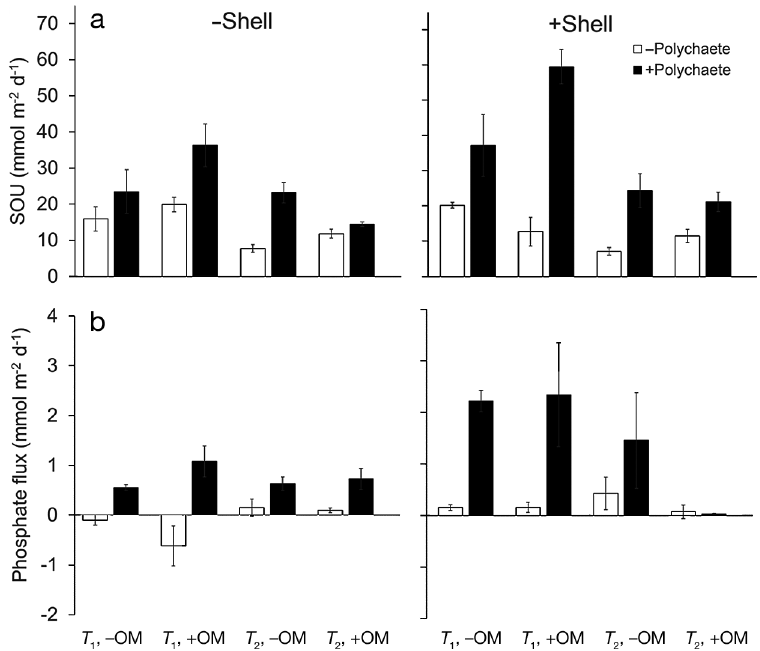
Fig. 5. Effects of shells on (a) sediment oxygen uptake (SOU) and (b) phosphate fluxes in sediments with different organic matter loads (+OM/−OM) and at 2 different sampling times ( T 1 : after 1 wk; T 2 : after 3 wk) in the presence and absence of polychaetes (−Polychaete/ +Polychaete) Table 5. ANOVA of sediment−water fluxes of ammonium, nitrate and nitrite in sediments affected by the experimental treatments. OM: organic matter Significant (p < 0.05) effects in Factor